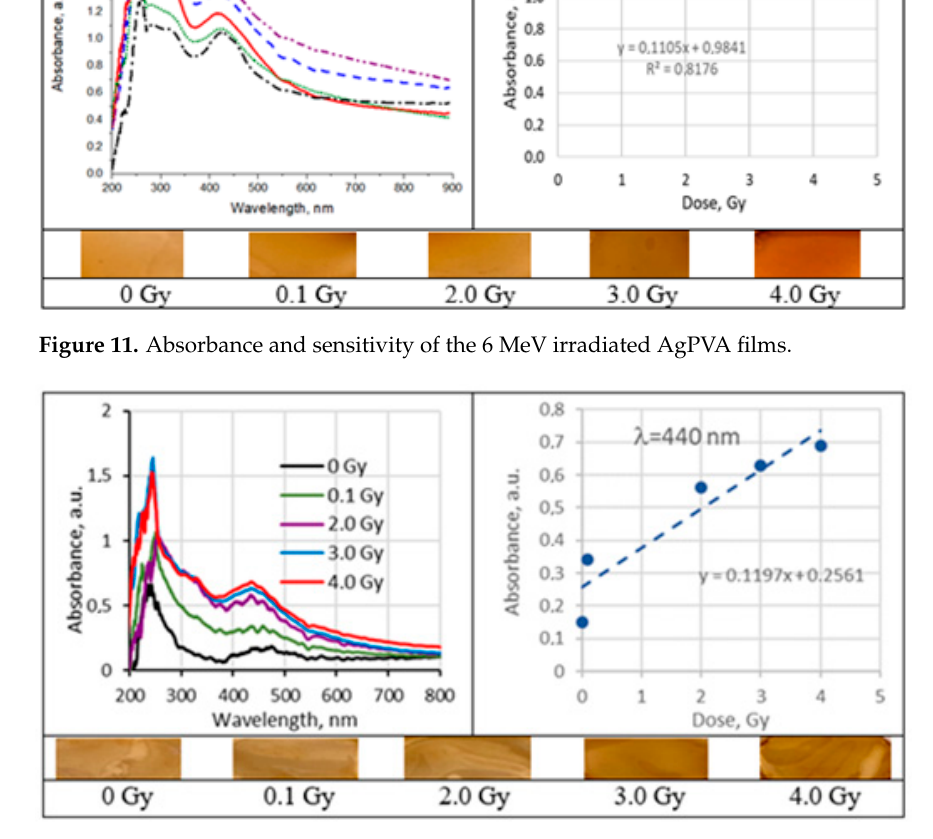
Figure 13. Absorbance and sensitivity of 6 MeV irradiated 1AgEthaPVA films.3. Discussions.